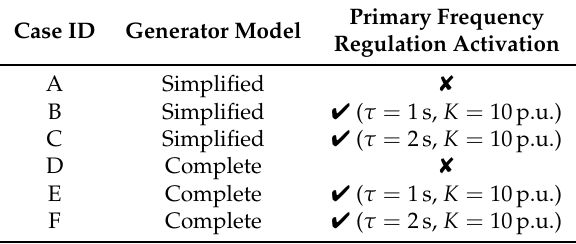
Figure 4. Comparison between two frequency transients. Table 1. Scenarios analyzed during the